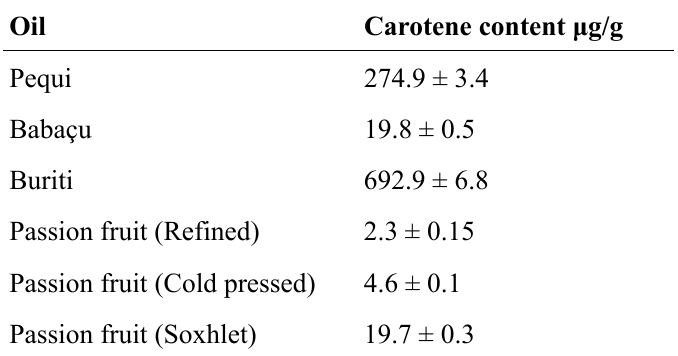
Table 5. Total carotene